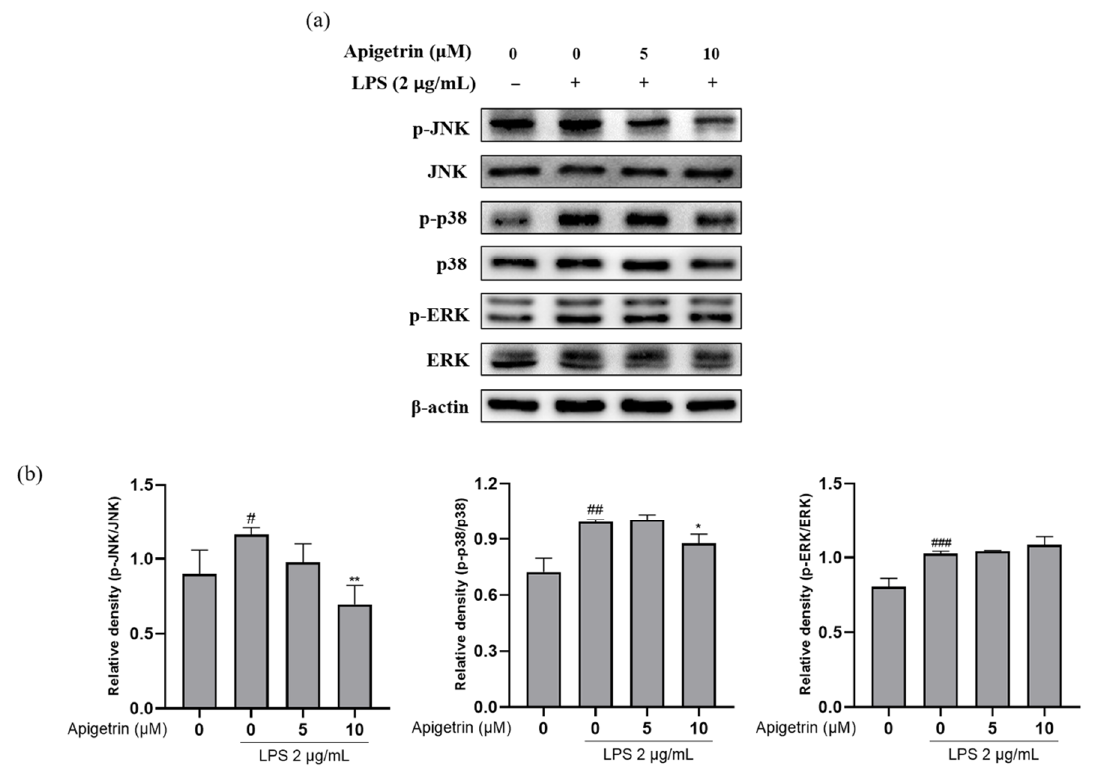
Figure 5. ( a ) Inhibitory effect of apigetrin on the LPS-induced protein expression of MAPK phos- phorylation in L6 cells. L6 cells were treated with apigetrin (0, 5, and 10 μM), with or without LPS, (2 μg/mL) for 24 h. Protein expression was determined by Western blotting. ( b ) The results are presented as the mean ± standard deviation (SD) of three independent experiments. # p < 0.05 vs. untreated group; ## p < 0.01 vs. untreated group; ### p < 0.001 vs. untreated group; * p < 0.05 vs. LPS-alone-treated group; ** p < 0.01 vs. LPS-alone-treated group.